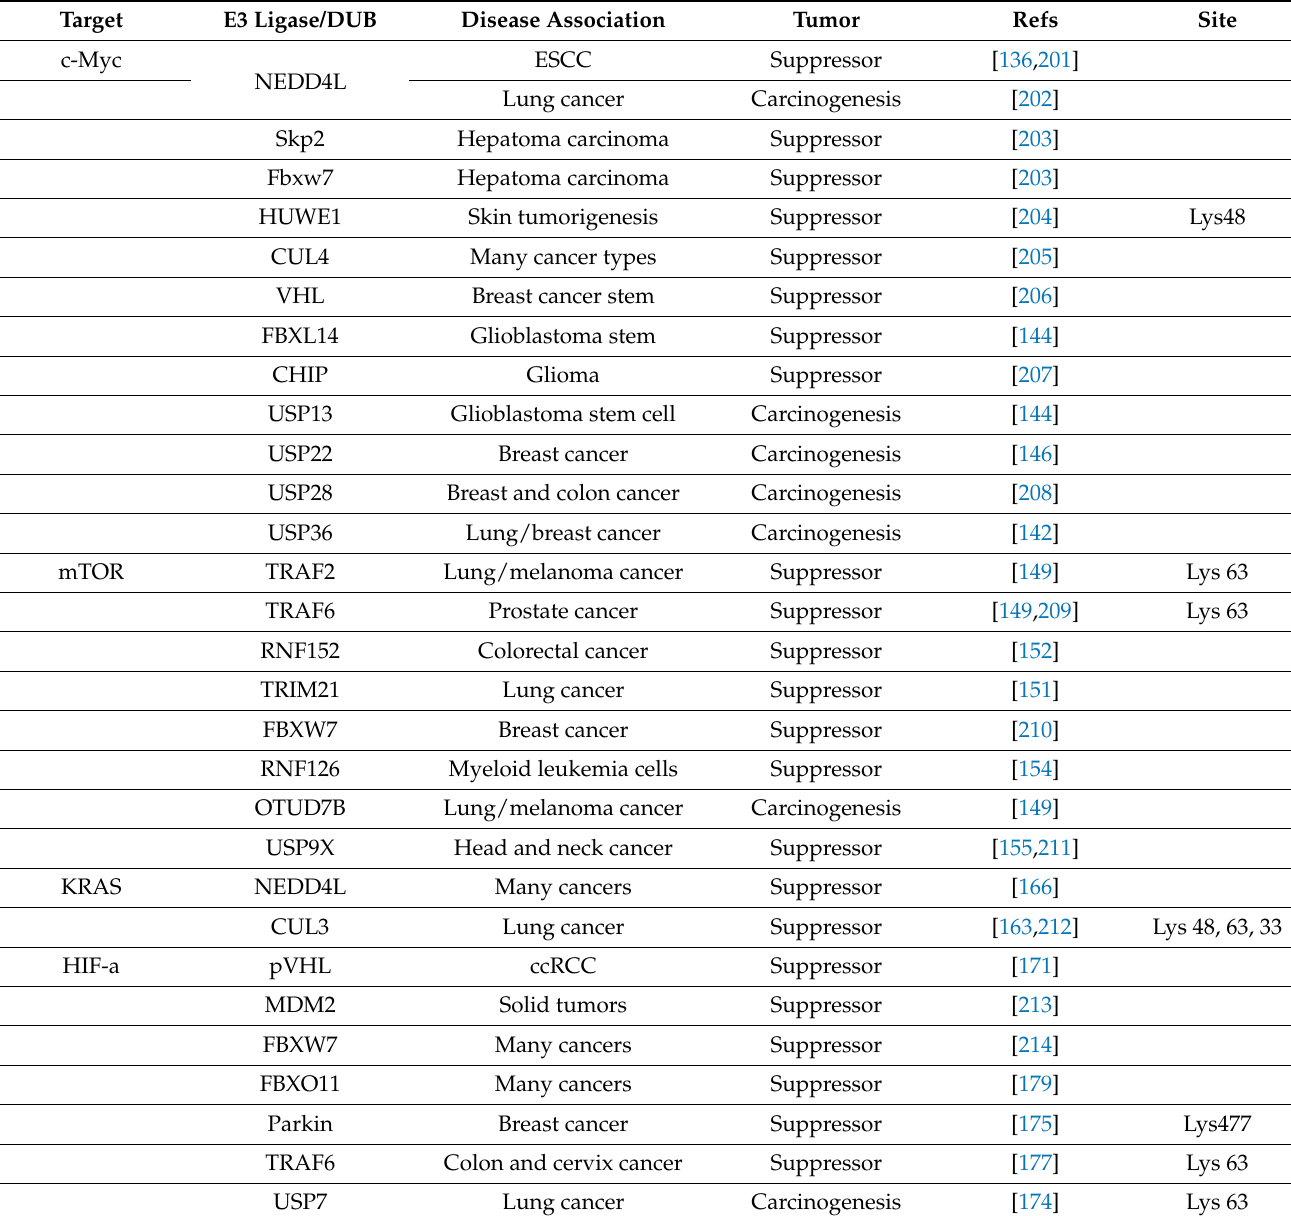
Table 1. The ubiquitination and deubiquitination of important signaling pathways in tumor